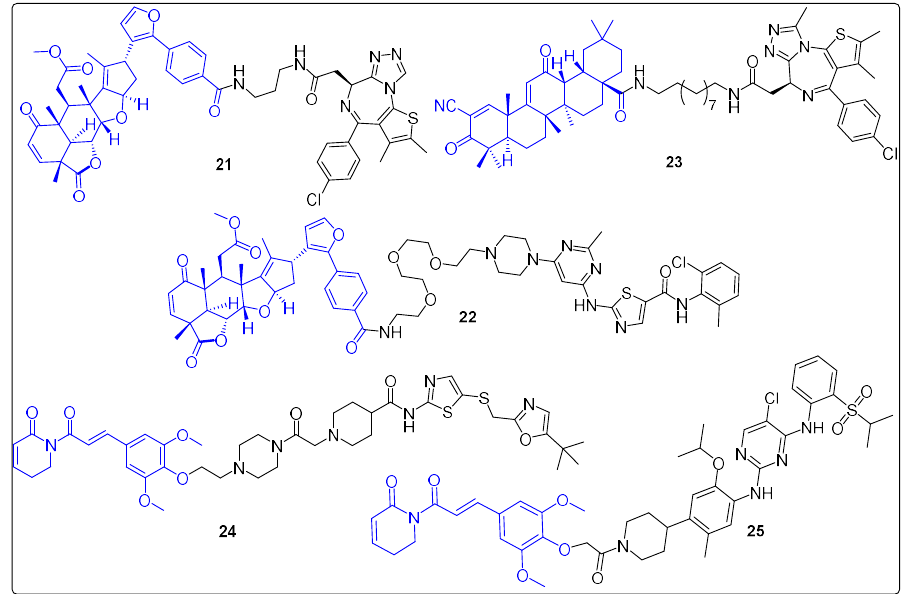
Figure 7. Natural products as E3 ligase recruiters and their